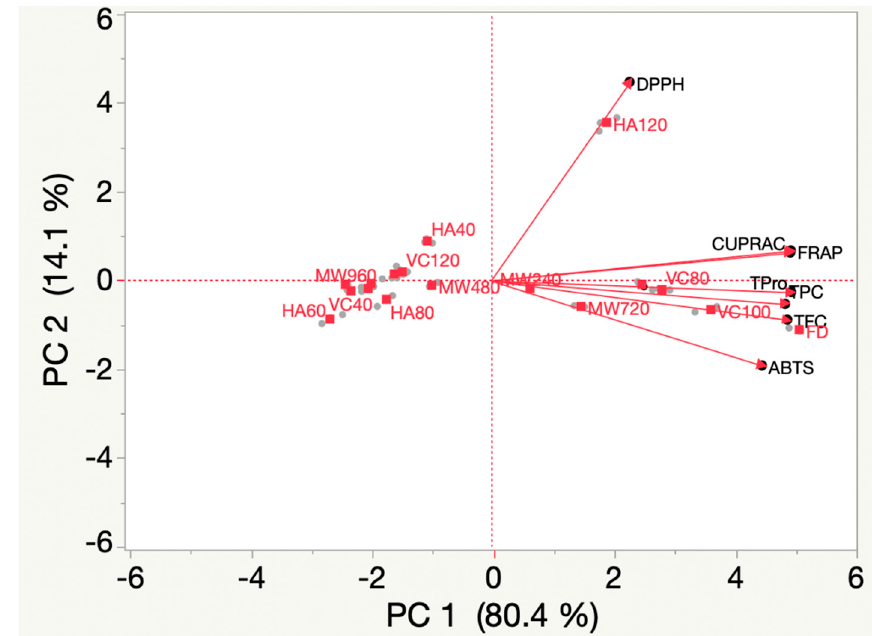
Figure 3. Loading plot for the principal components analysis (PCA) of the first two factors.